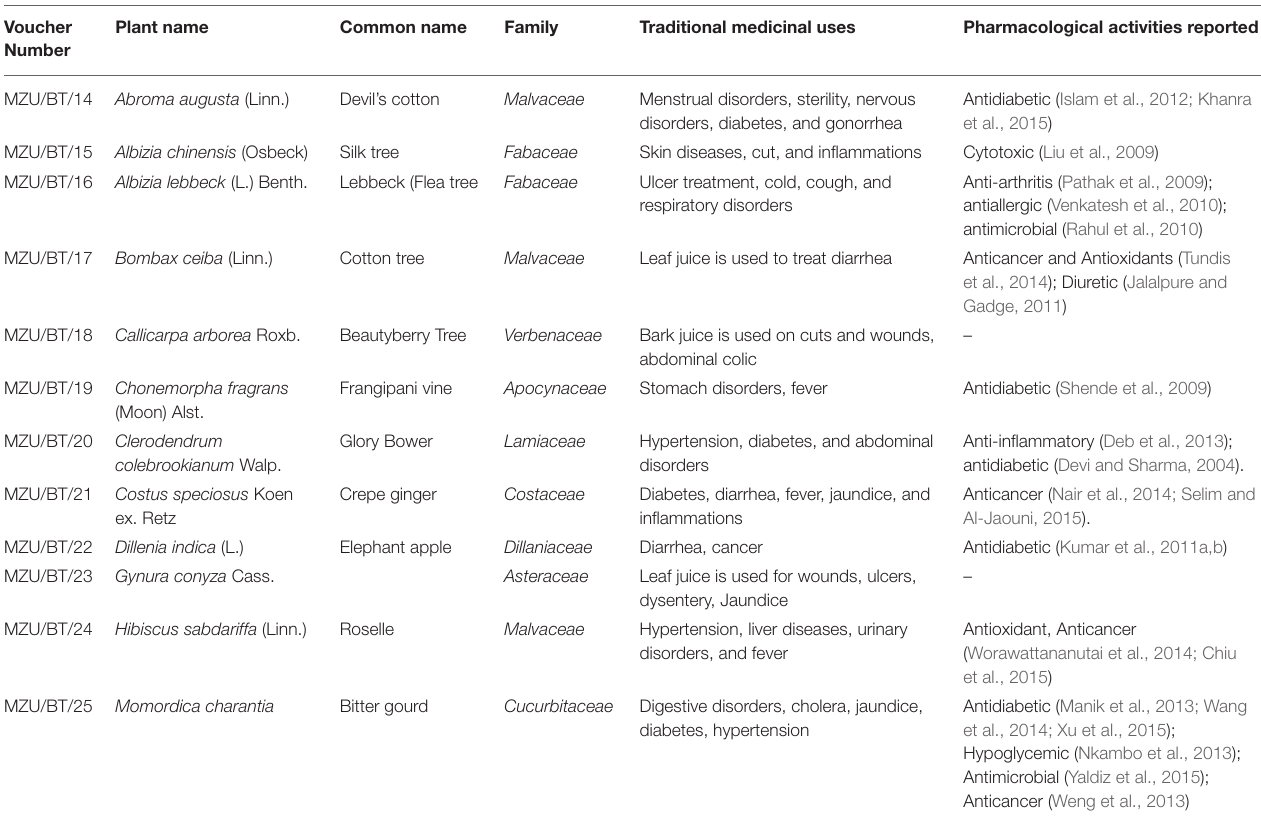
TABLE 1 | General characteristics and pharmacological activities of the selected medicinal